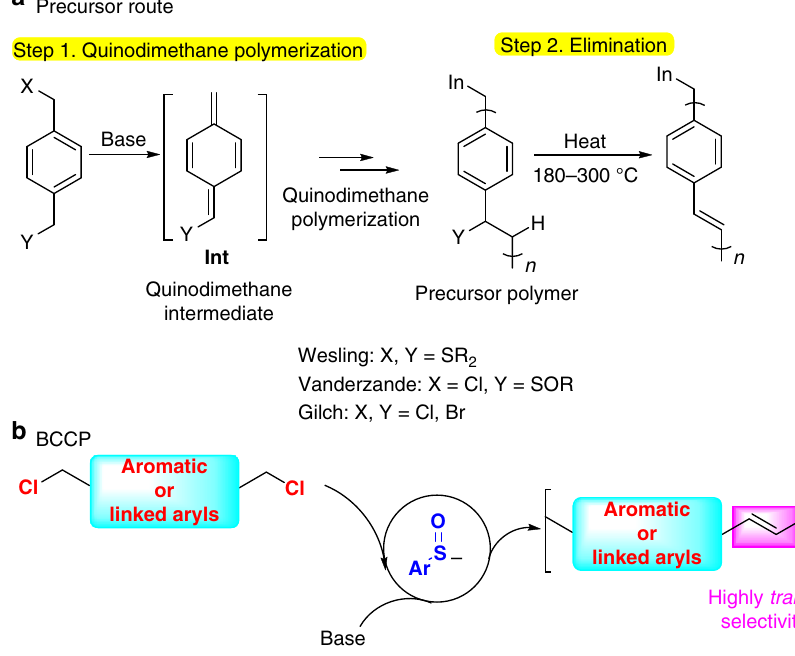
Fig. 4 Comparison of BCCP polymerization with precursor routes. a Summary of precursor route. b BCCP polymerization